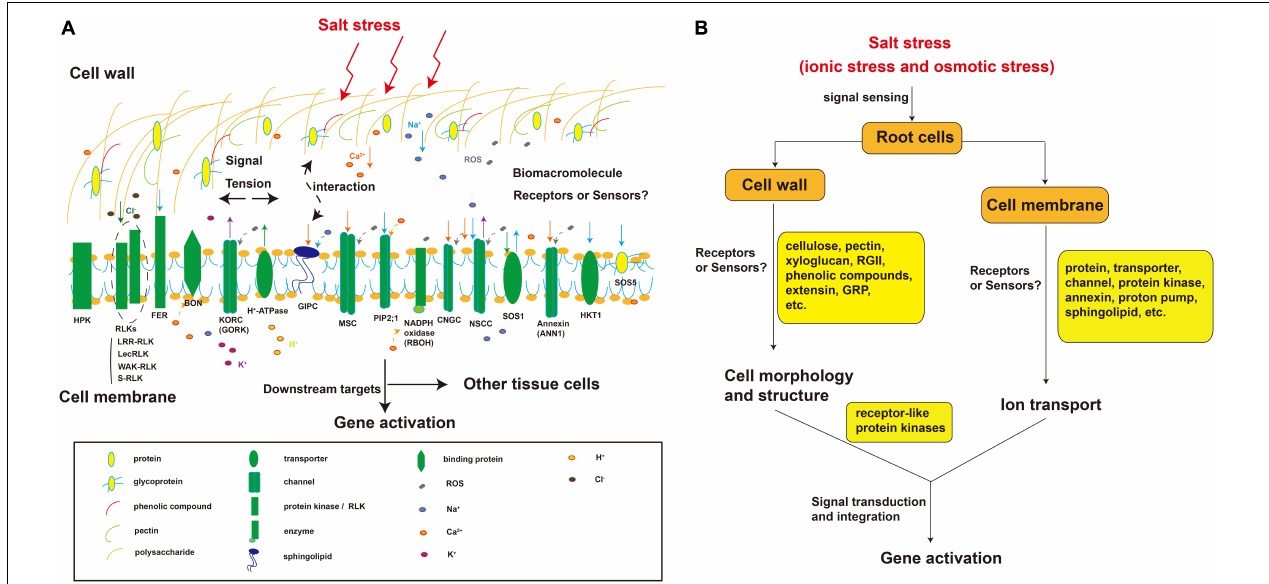
FIGURE 2 | Putative components sensing physical and chemical signals in the plant root cell wall and plasma membrane under salt stress. (A) Cellular distribution of components known to be or that might be involved in salt stress perception; (B) The salt stress sensing process mediated by cell wall and plasma membrane components. The components in the cell wall and cell membrane perceive salt stress. Salt stress causes cell deformation. In the cell wall, the polysaccharides (e.g., cellulose, xyloglucan, and pectin RG-II), phenolic compounds, and proteins (e.g., GRP, glycoproteins, and extensin) undergo conformational changes due to the perception of a certain factor or binding with a certain substance such as Na + . Similarly, plasma membrane components such as proteins (e.g., annexin), transporters (e.g., SOS1), channels (e.g., CNGC), kinases (e.g., HPK), and sphingolipids (e.g., GIPC) also cause conformational changes in the cell wall or membrane followed by a series of biochemical reactions due to the sensing of a certain factor or binding with a certain substance such as Na + . These receptor-like components can also interact with each other to sense signals. RG-II, Rhamnogalacturonan II; GRP, glycine-rich protein; MSC, mechanosensory channel; CNGC, cyclic nucleotide-gated channel; HPK, histidine protein kinase; RBOH, NADPH